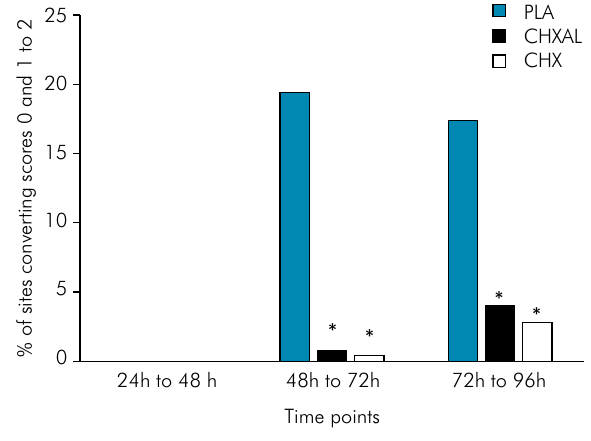
Figure 2. Analyses of the conversion of scores 0 and 1 into score 2, for all dental surfaces, stratified by solution (PLA, placebo; CHXAL, alcohol-containing chlorhexidine; CHX, alcohol-free chlorhexidine) and time point of analysis (n = 35). * Statistically significant difference from placebo (Friedman and McNemar tests, p <